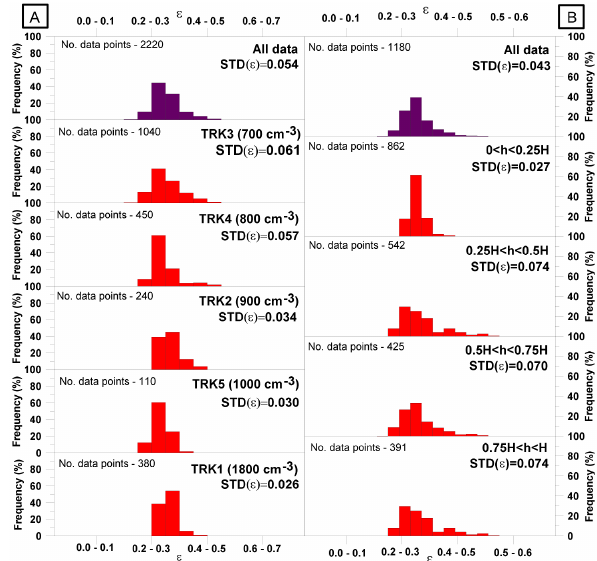
Figure 7. (a) Histograms of ε for different aerosol loading values. The average aerosol loading for each flight (calculated at cloud base height) is presented. All histograms are based only on measured data associated with N c >10cm − 3 . (b) Histogram of ε for different height ranges above the cloud base (indicated individually for each histogram by “h” range of the total cloud depth, “H”), excluding data collected during flight TRK3. All histograms are based only on measured data associated with N c >10cm − 3 . The top panel (All data) is based on data collected during all flights. Data collected during flight TRK3 were not used for any of the